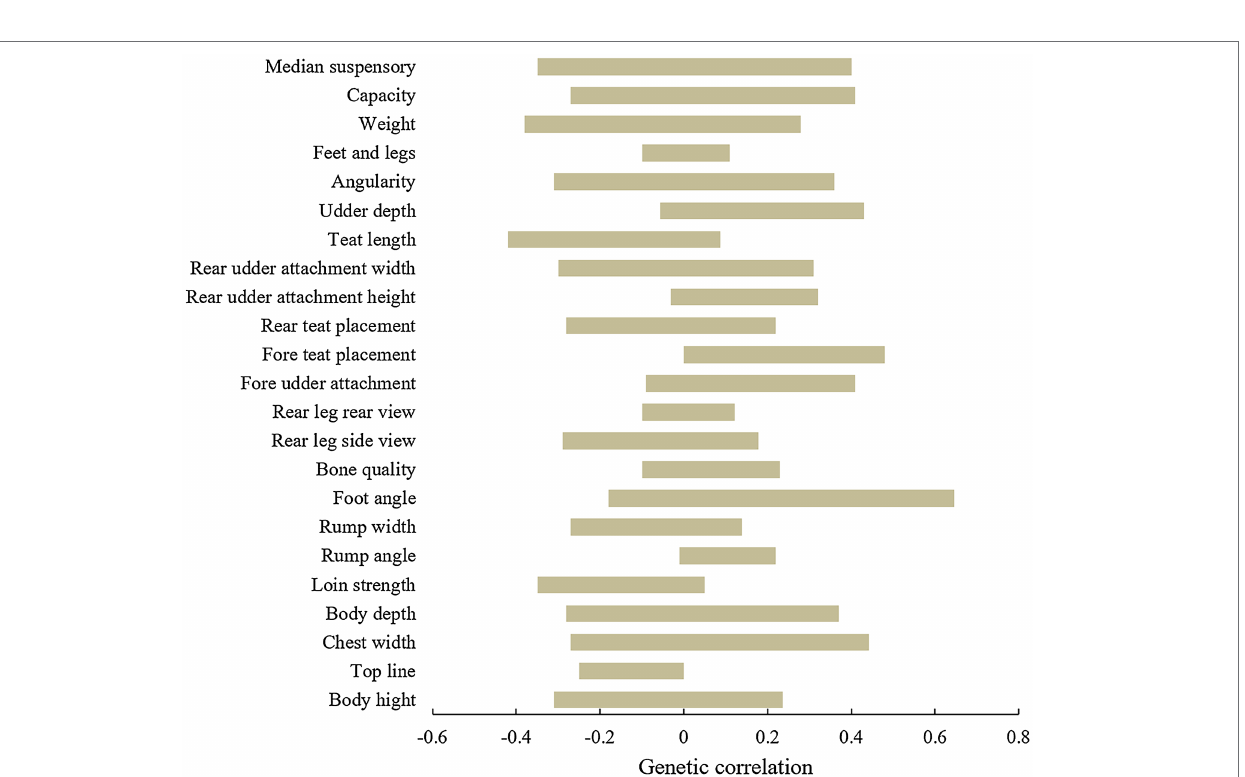
FIGURE 2 | Genetic correlations between longevity and type